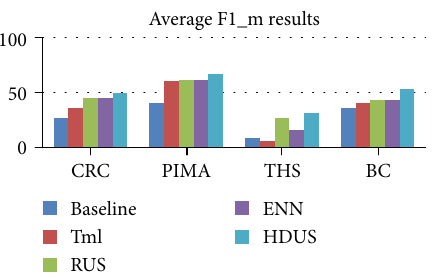
Figure 2: The average F1_m results using models (baseline, Tml, RUS, ENN, and HDUS) for four datasets.